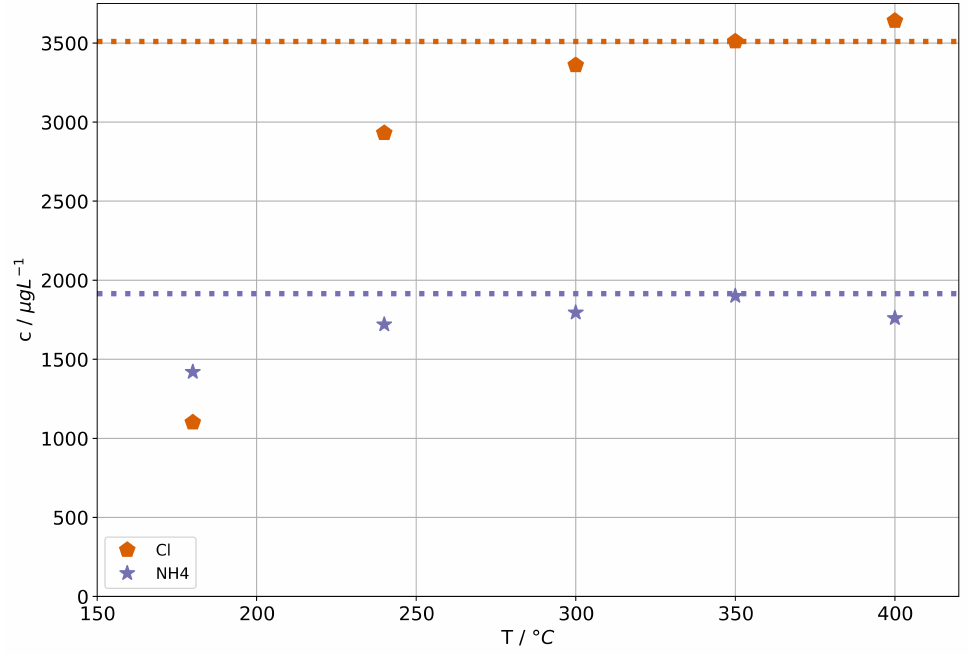
Figure 3. Ammonium and chloride concentrations in condensates for the AG-SG. Dashed lines indicate the concentrations in the feed-water